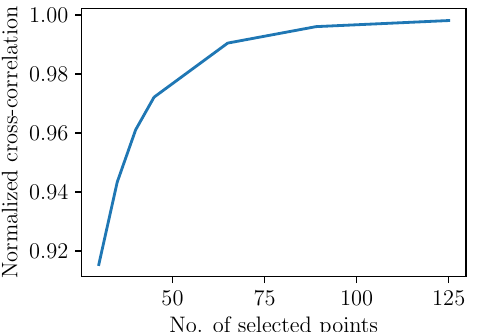
Figure 1. NCC values for different versions of downsampled EEG signals.